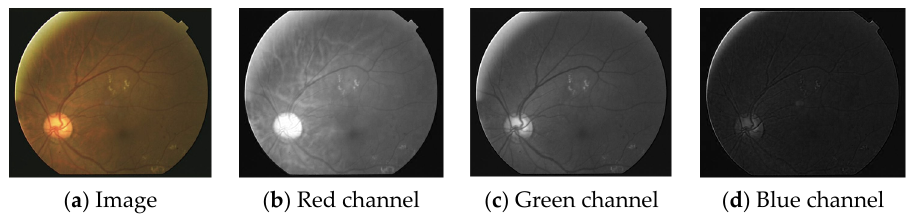
Figure 1. A fundus image with strong boundary reflectance at its top left border with its red, green and blue channels.